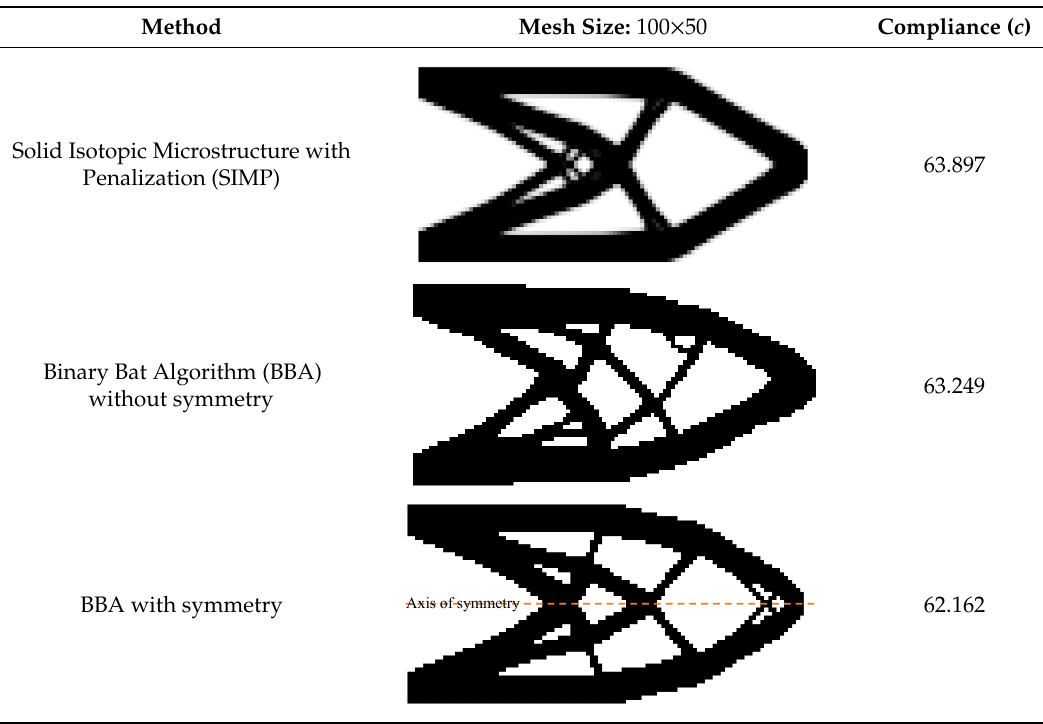
Table 1. Comparison of the best topologies of the cantilever plate (case 1).